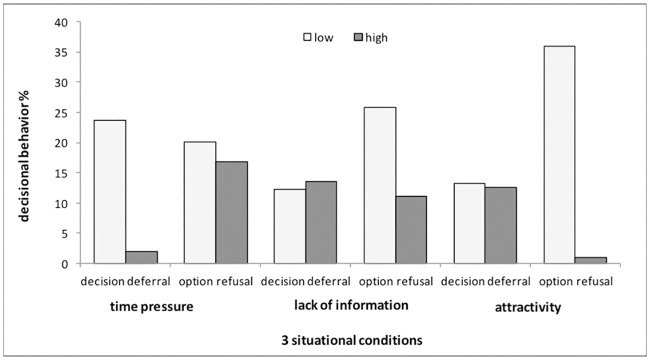
The three situational factors “time pressure”, “lack of information,” and “attractivity” of the choice-set (white: low; dark: high) and the respective probabilities of decision deferral and option refusal (in percent).